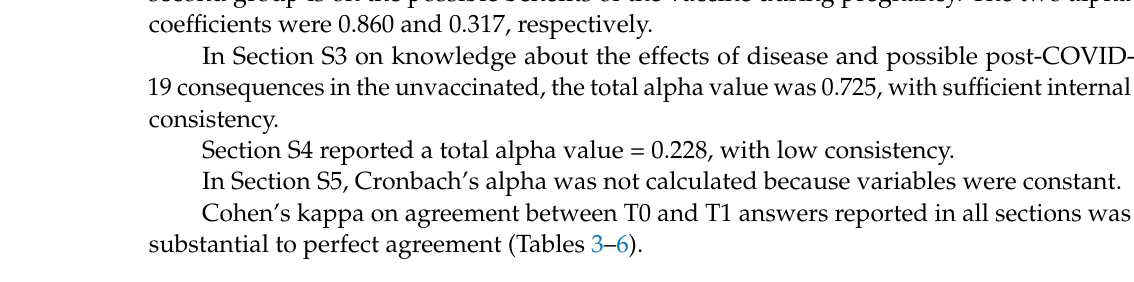
Table 3. Descriptive and reliability of “Section S2: Knowledge about COVID-19 vaccination” ( n =